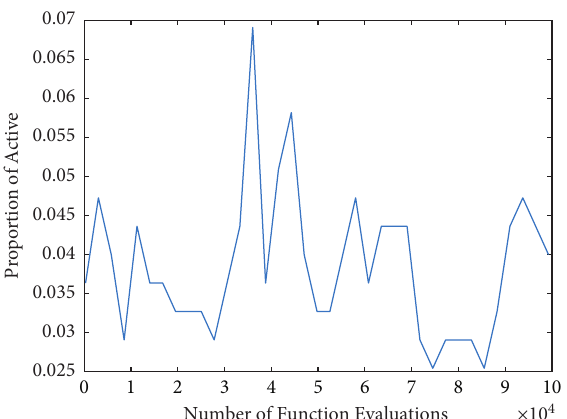
Figure 2: The proportion of active reference vectors during the optimization of 10-objective MaF1 by